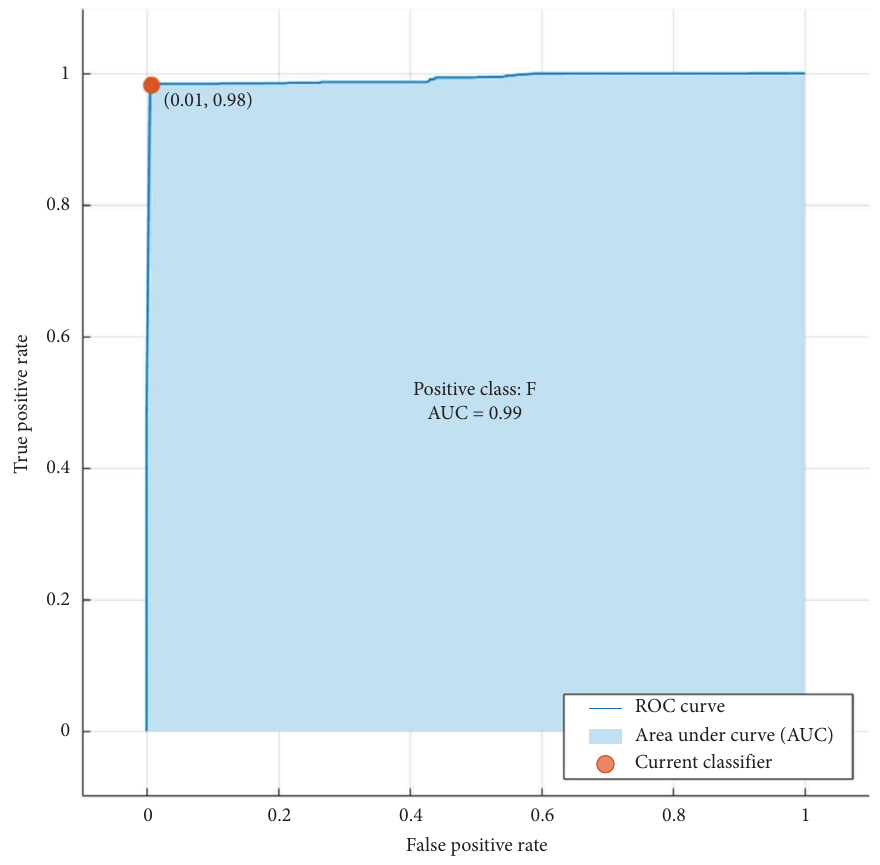
Figure 13: ROC curve for class F. Table 3: Validation of the proposed method for computational timing analysis in Google